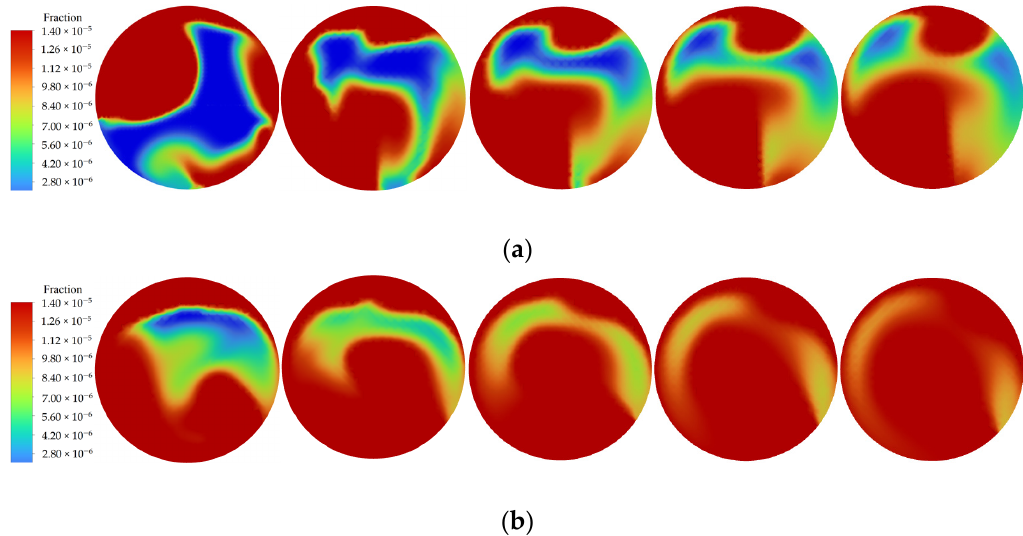
Figure 10. Concentration distribution of the outlet pipe: ( a ) before optimization; ( b ) after optimiza- tion.